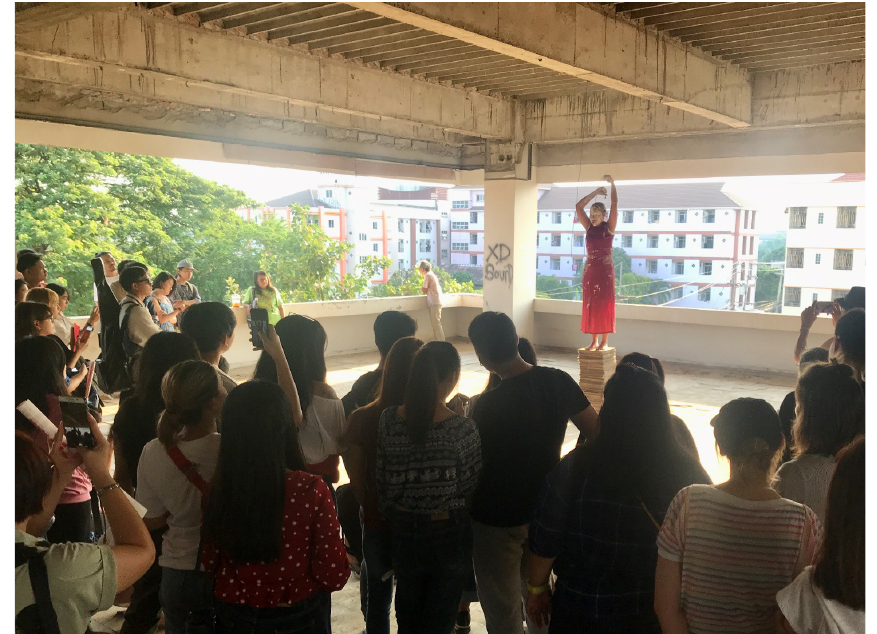
Figure 3. The Monument in the Motherland performance by Wilawan Wiangthong at Khon Kaen Manifesto in Khon Kaen (October 2018). Photo by the authors.